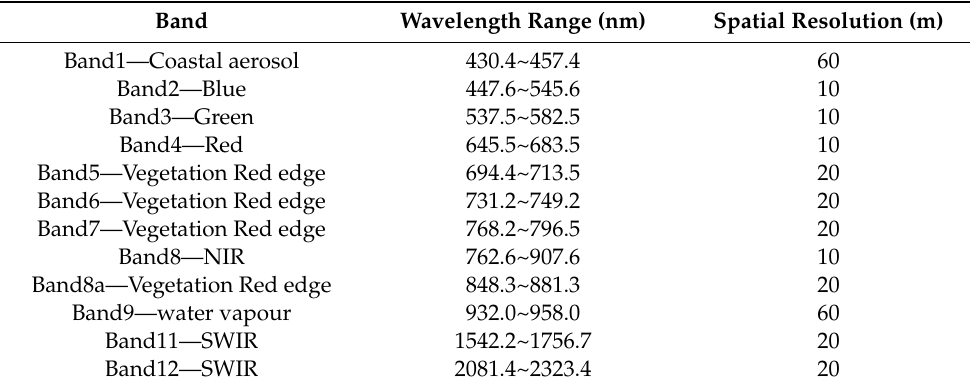
Table 2. Spectral bands of the Sentinel-2a L2A used in this study.